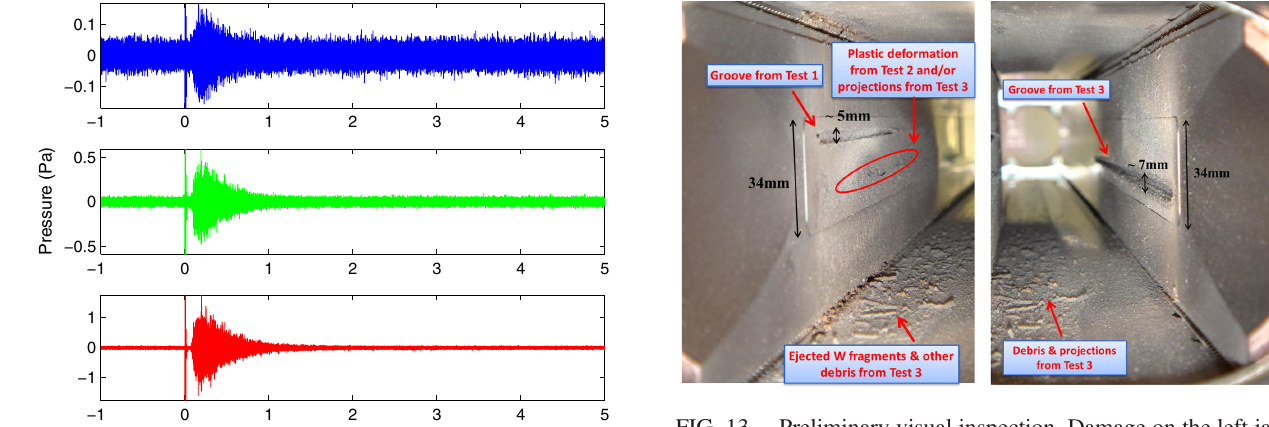
FIG. 13. Preliminary visual inspection. Damage on the left jaw caused mainly by Test 1 beam impact (left). Damage on the right jaw caused by Test 3 beam impact (right). Marked dimensions of the grooves only take into account the estimated height of the